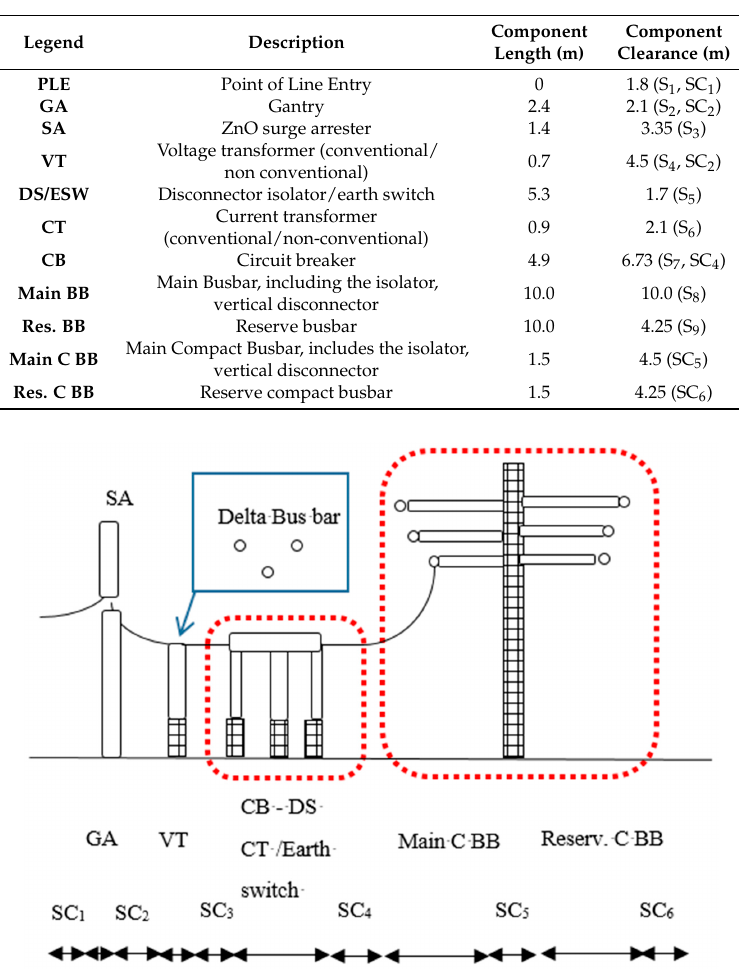
Figure 6. Proposed line entry compact bay configuration.